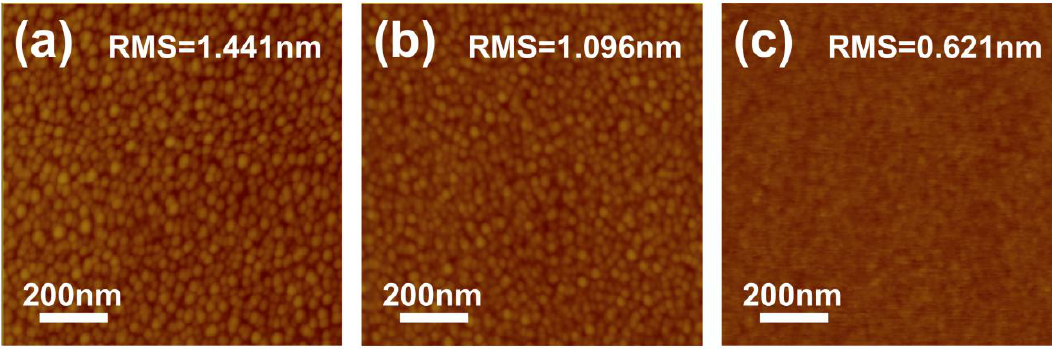
Figure 4. AFM images of Ar/O and ( c ) −110